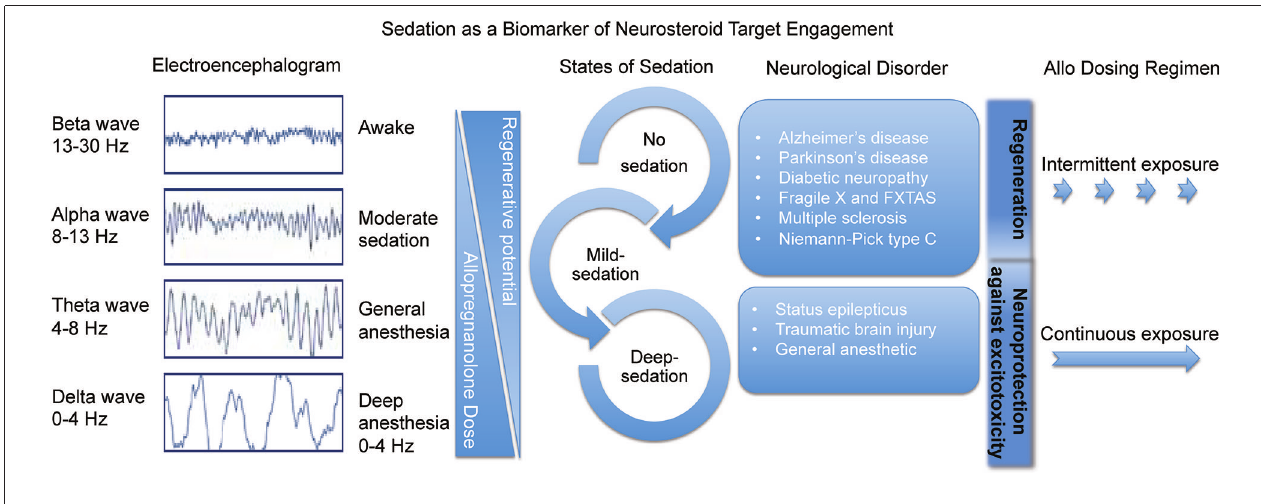
intermittent pulses, Allo is beneficial for many neurological disorders. In status epilepticus and traumatic brain injury it is important to deliver sedative doses of continuous Allo to protect the brain from further